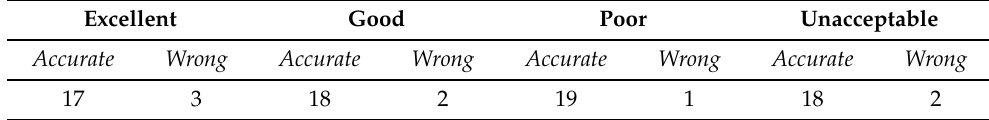
Table 7. Statistical results for cell-level service perception